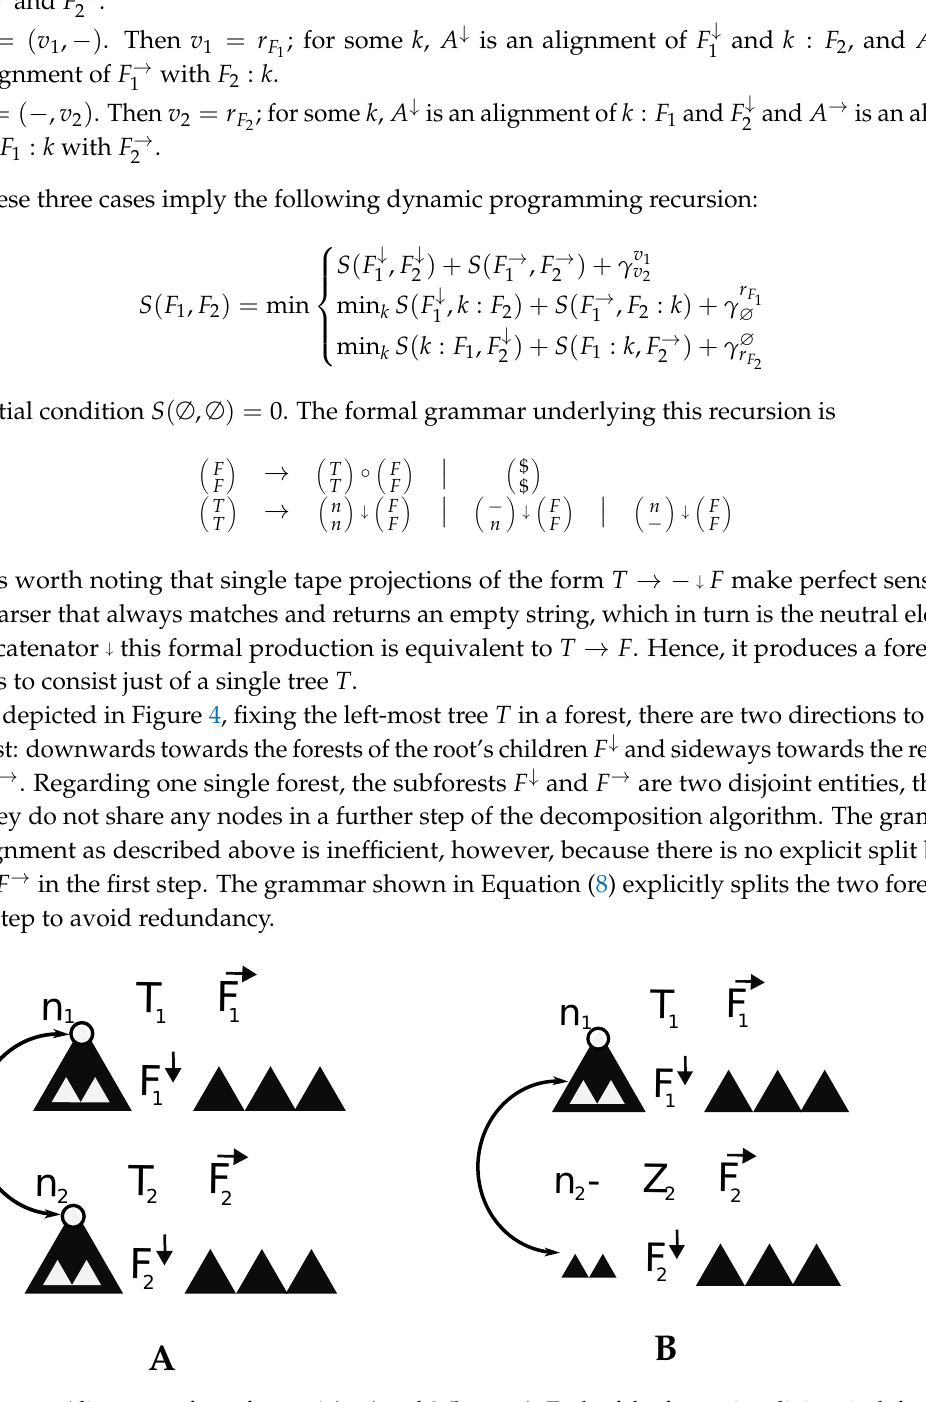
Figure 4. Alignment of two forests 1 ( top ) and 2 ( bottom ). Each of the forests is split into its left-most tree T 1 , T 2 and the remaining forest F → n 1 , n 2 and the forests of its children, F ↓ recursion continues with F ↓